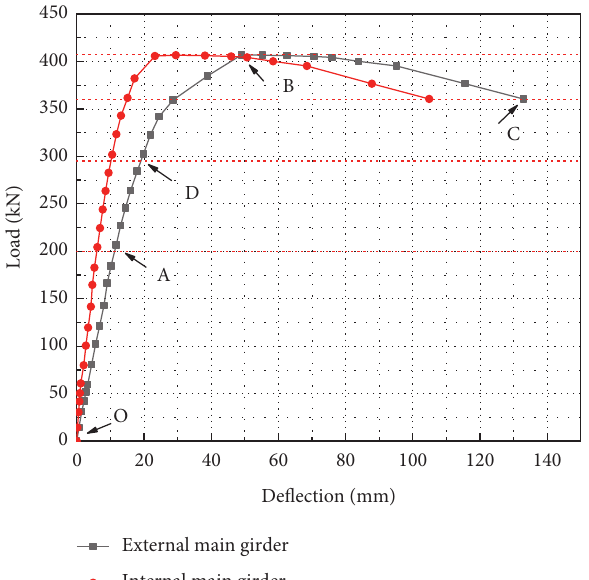
Figure 7: Load-deflection curves at the intermediate support